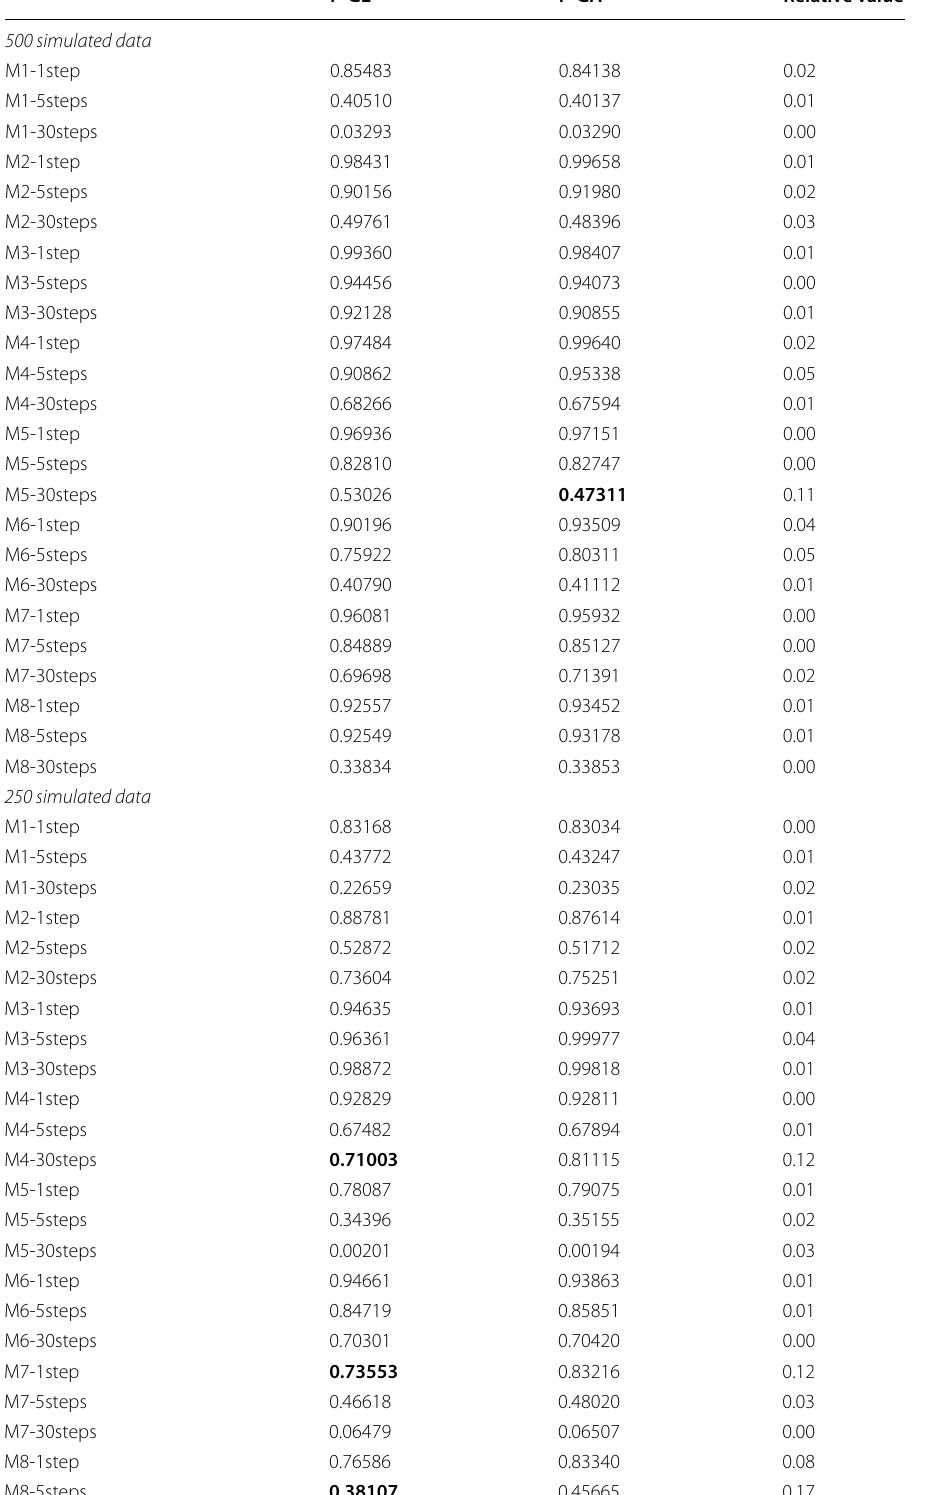
Table 10 Comparisons of P-GE-NoVaS and P-GA-NoVaS methods